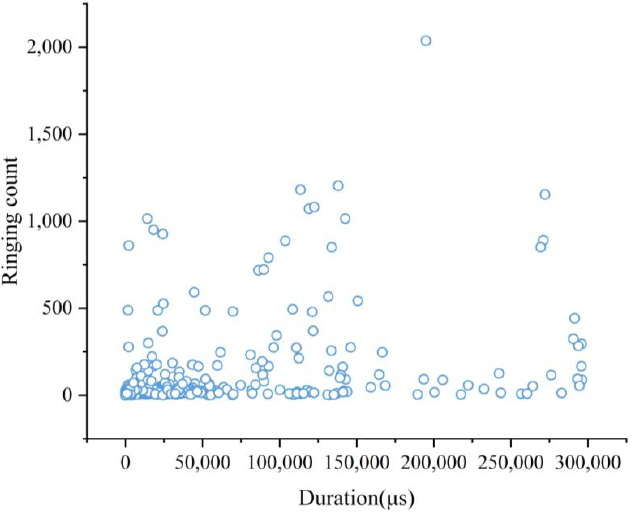
Figure 11. Ring count-duration correlation diagram of cable noise signal of Yangma Island Bridge.